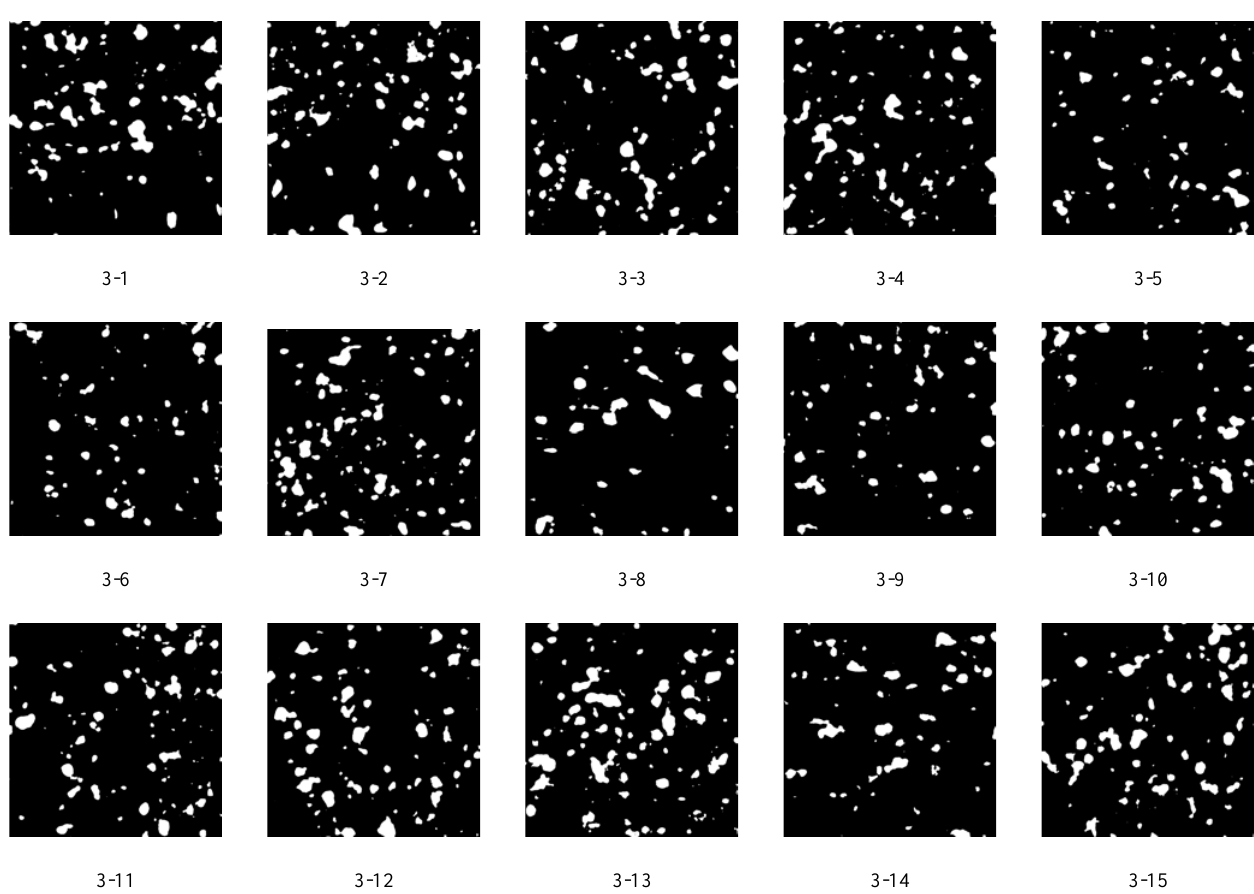
Fig. 4. Binary image of PVPP distribution of di®erent hardness in Yinhuang dispersible